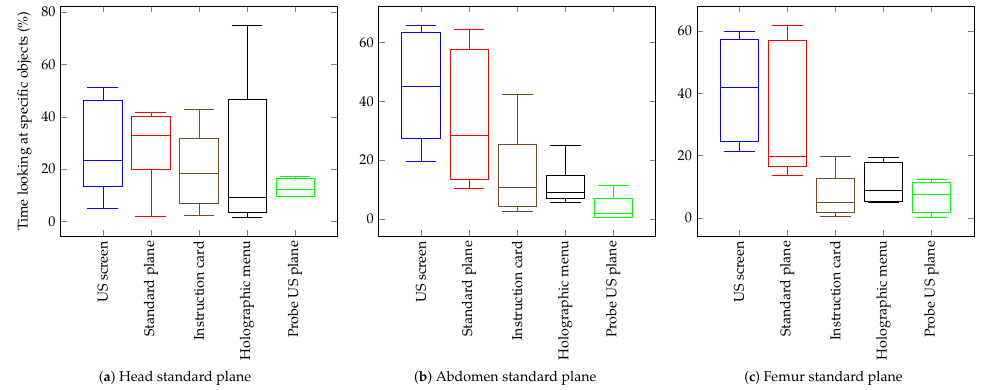
Figure 7. Visual attention profiles of study participants during standard plane navigation: Amount of time (in %) spent looking at specific game objects during navigation to the three standard planes, namely ( a ) head, ( b ) abdomen; and ( c )